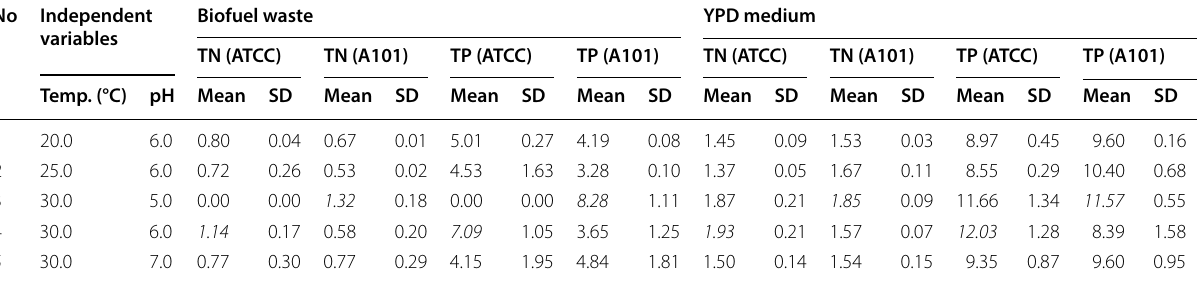
TN, total nitrogen; TP, total protein; ATCC, Y. lipolytica ATCC 9793; A-101, Y. lipolytica A-101